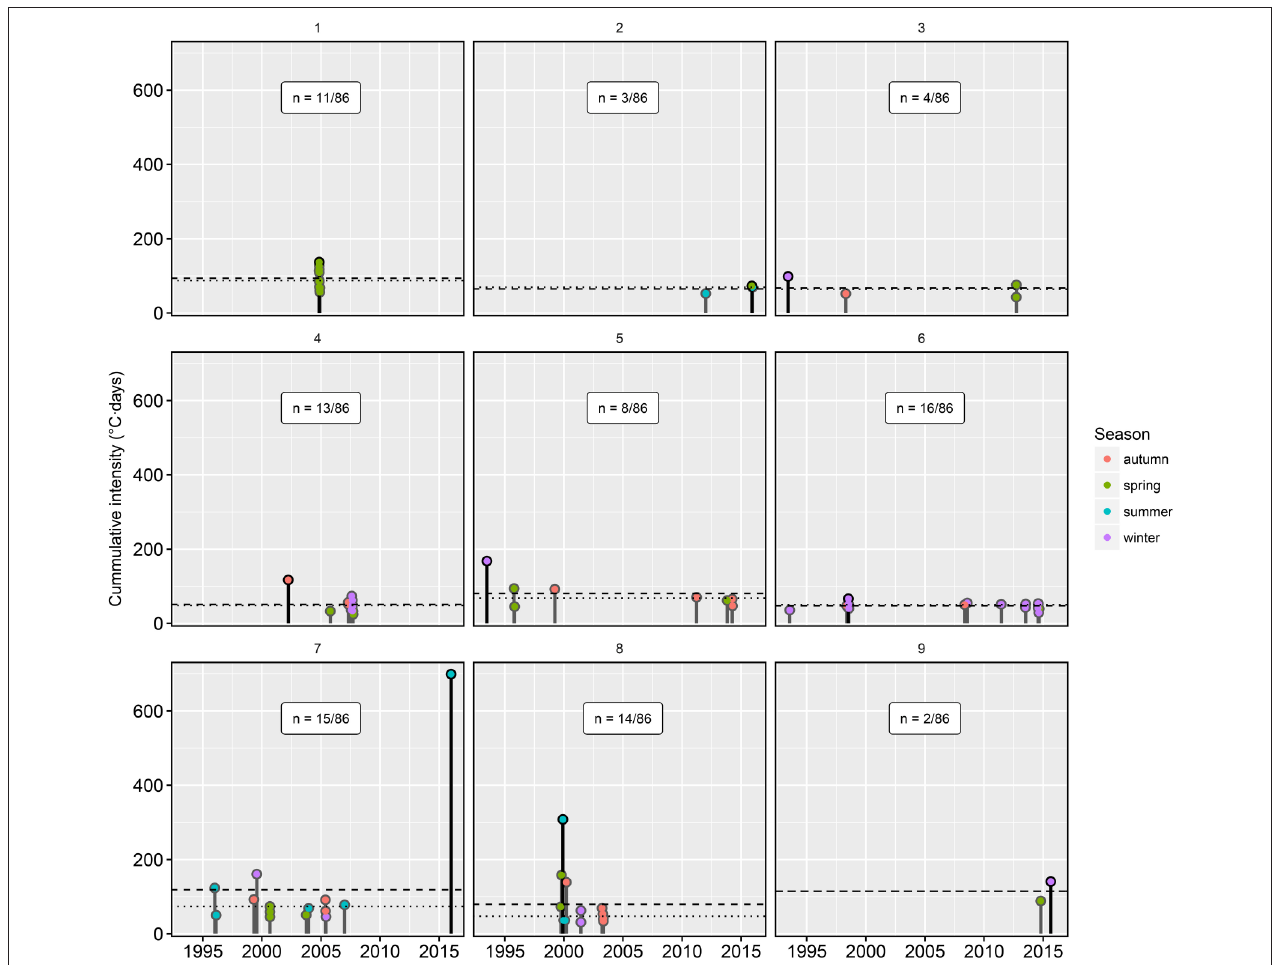
FIGURE 5 | Lolliplot showing the start date for each marine heatwave (MHW) within each node as seen in Figure 4 , with the portion of total events per node shown within the white label in the middle of each panel. The height of each lolli shows the cumulative intensity of the event, as outlined in Table 1 , while the lolli color denotes the season during which the event